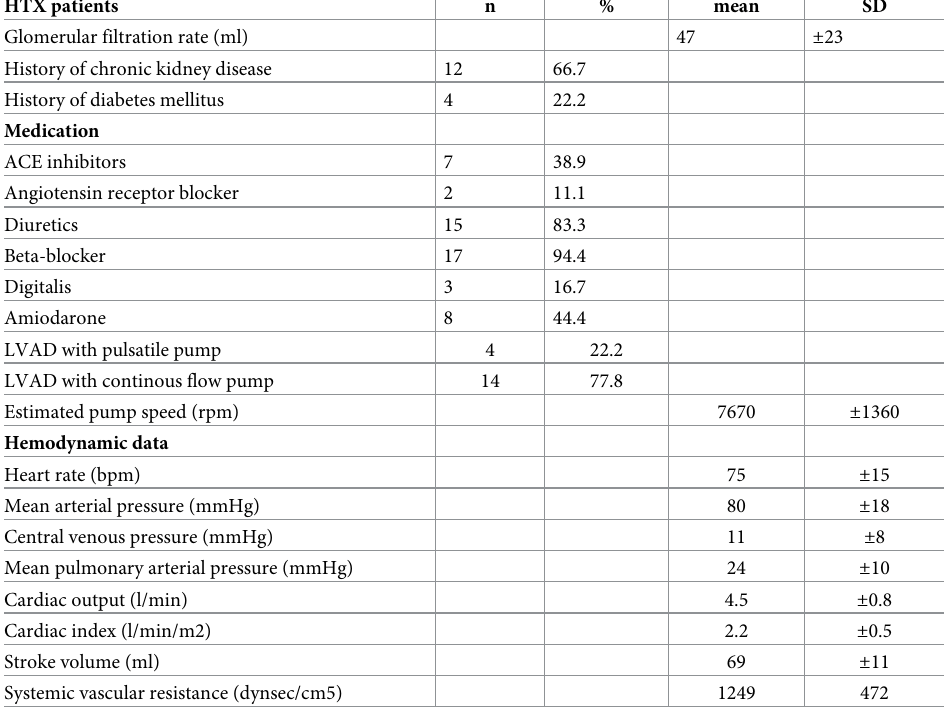
Systemic vascular resistance (dynsec/cm5) 472 Data are presented as absolute values with corresponding percentages or as mean values ± standard deviation. SD = Standard Deviation; BMI = Body Mass Index; LVEF = Left Ventricular Ejection Fraction; LVEDD = Left Ventricular Enddiastolic Diameter; LAD = Left Atrial Diameter; BNP = Brain Natriuretic Peptide; ACE = Angiotensin-Converting Enzyme; LVAD = Left Ventricular Assist Device.